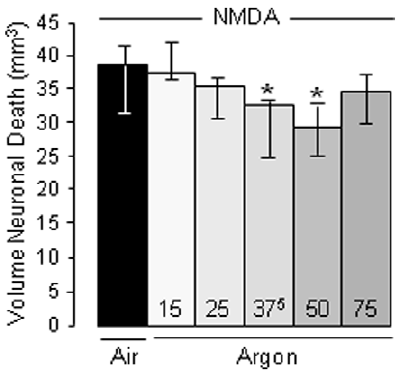
Figure 2. Concentration-response effects of argon (Ar) on NMDA-induced neuronal death (n=7–11 per group). Injection of NMDA led to significant neuronal death. Sham rats had no brain damage data not shown). Rats treated with argon at 37.5 vol% and 50 vol% had a significant reduction of neuronal death as compared to NMDA control animals treated with medical air. Data are expressed